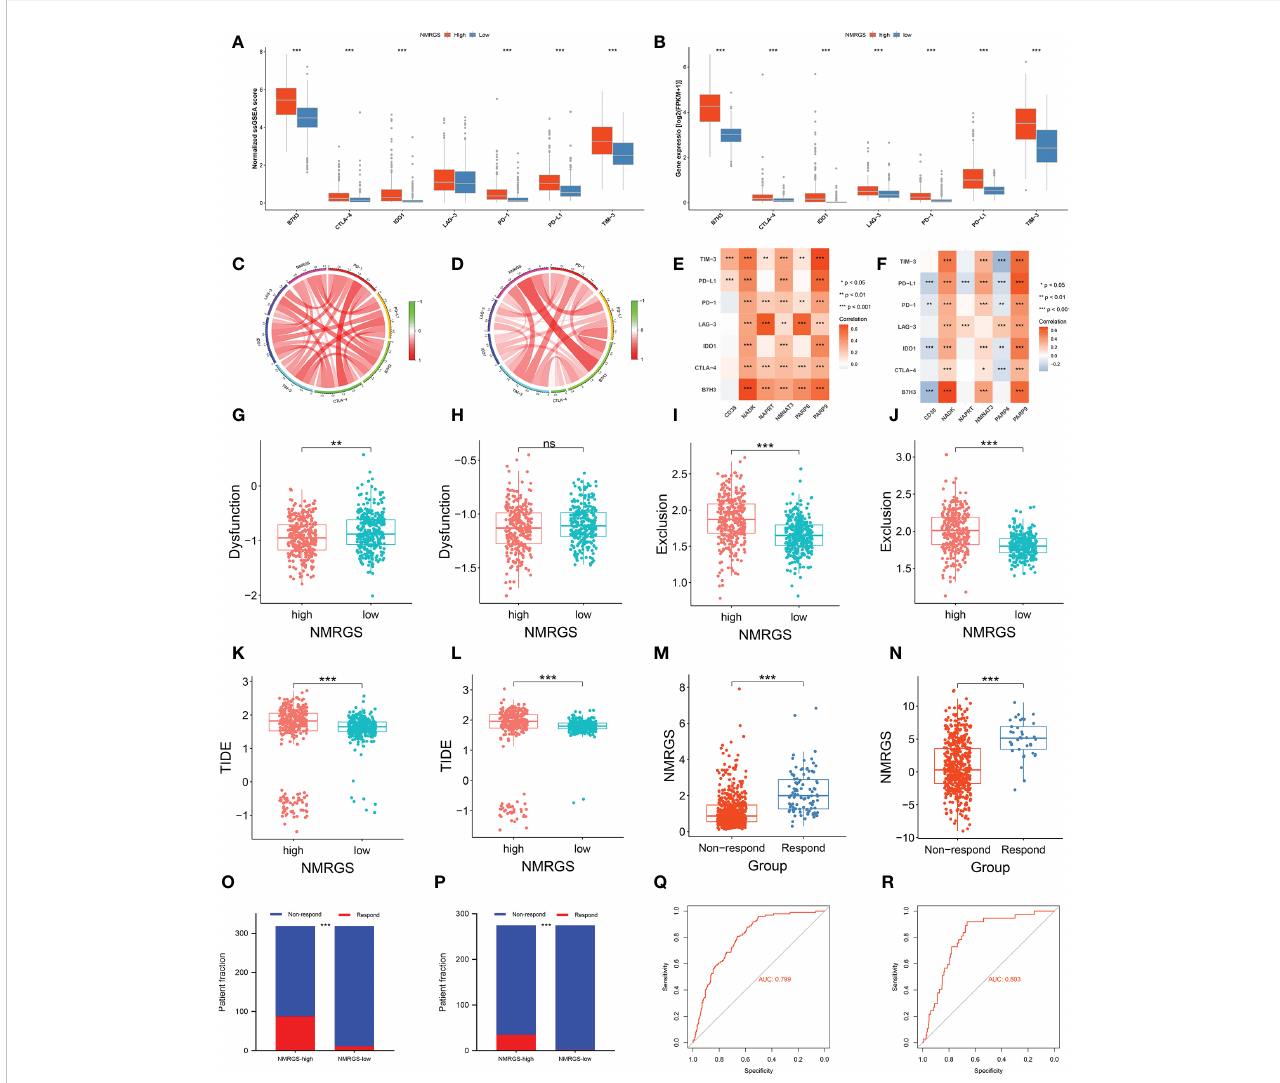
FIGURE 9 Association between NMRGS and ICI therapy response. (A, B) Comparison of representative immune checkpoints between NMRGS-low group and NMRGS-high group in CGGA693 and TCGA cohorts. (C, D) Analyses of correlation between NMRGS and representative immune checkpoints expression in CGGA693 and TCGA cohorts. (E, F) Analysis of correlation between the hub genes and representative immune checkpoints expression in CGGA693 and TCGA cohorts. (G – L) Comparison of dysfunction score, exclusion score, and TIDE score between NMRGS-low group and NMRGS-high group in CGGA693 and TCGA cohorts. (M, N) Comparison of NMRGS score between responders and non- responders in CGGA693 and TCGA cohorts. (O, P) Patient fraction of responders and non-responders in NMRGS-low group and NMRGS-high group. (Q, R) ROC curve analysis of NMRGS in predicting the ef fi cacy of ICI